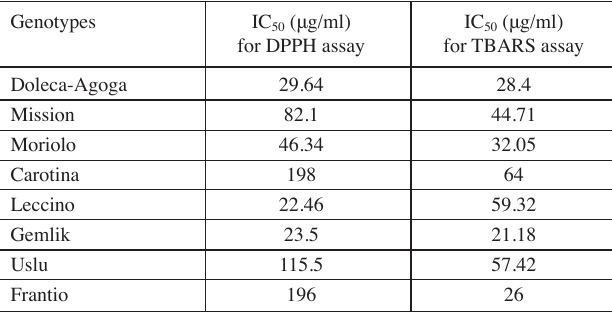
Tab. 1: IC 50 values of different genotypes of